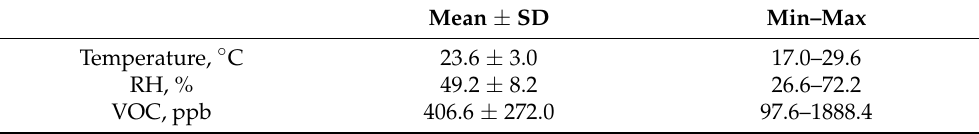
Table 3. 24-Hour mean air quality characteristics of measured